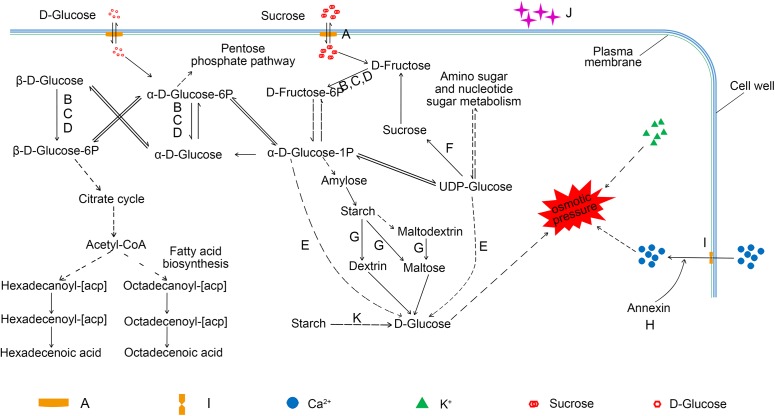
An overview of the pathway for proteome metabolic changes between YM18 and ZK001.(A) A0A1D6CCI3 (bidirectional sugar transporter SWEET); (B) A0A1D5SYC3 (cellular glucose homeostasis-related proteins); (C) A0A1D5RVB4 (cellular glucose homeostasis-related proteins); (D) A0A1D5VEI9 (cellular glucose homeostasis-related proteins); (E) A0A077S2F2 (beta-glucosidase activity-related protein); (F) W5B5R3 (sucrose synthase); (G) A0A1D5RR02 (beta-amylase); (H) A0A1D5RRV7 (annexin); (I) A0A1D5TN57 (calcium ion binding-related protein); (J) A0A1D5WGA3 (nutrient reservoir-related protein); (K) P93594 (beta-amylase).